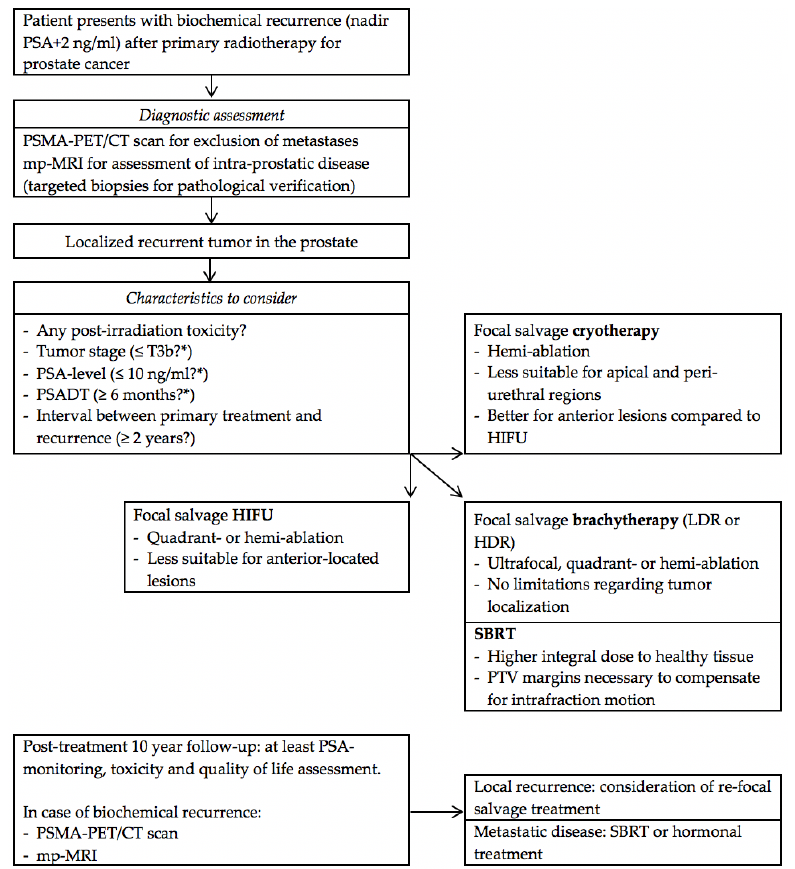
Figure 2. Flow chart for decision-making before and after focal salvage treatment of localized radiorecurrent prostate cancer. Abbreviations : PSMA: prostate-specific membrane antigen, mp-MRI: multiparametric magnetic resonance imaging, PSADT: PSA doubling time, HIFU: high-intensity focused ultrasound, LDR: low-dose-rate, HDR: high-dose-rate, SBRT: stereotactic body